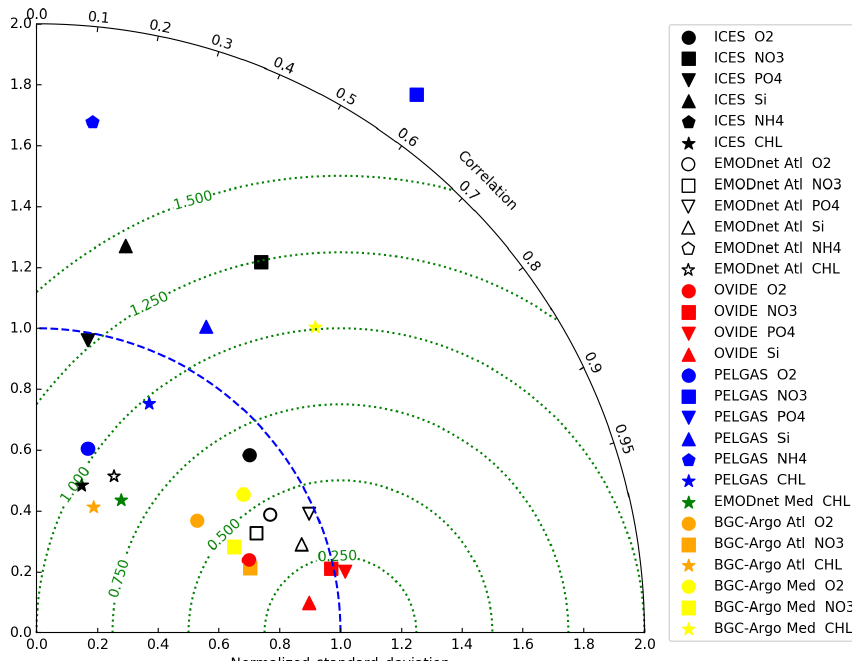
Figure 7. Taylor diagram summarising the skill of the IBI36 system to estimate the main biogeochemical variables: oxygen (circle), nitrate (square), phosphate (triangle pointing upwards), silicate (triangle pointing down), ammonium (pentagon) and Chl a (star) from ICES (black), North Atlantic EMODnet product (white), OVIDE (red), PELGAS (blue), Mediterranean EMODnet product (green), APEX BGC-Argo in the Atlantic (orange) and PROVOR BGC-Argo in the Mediterranean (yellow).